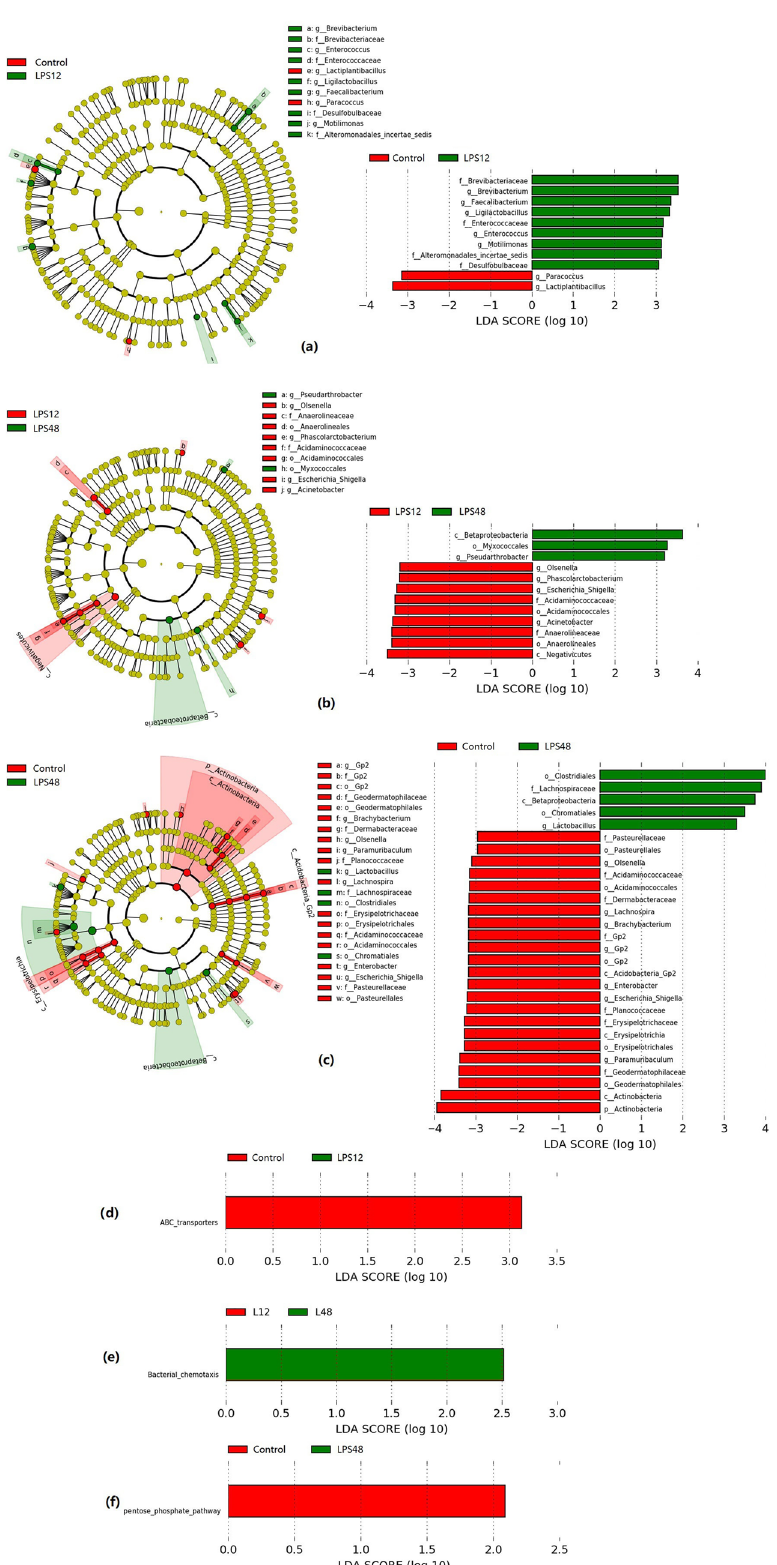
Figure 5. Linear discriminant effect size (LEfSe) analyses comparing differentially abundant taxa and Kyoto Encyclopedia of Genes and Genomes (KEGG) pathways between different groups. ( a – c ) Differences in the lung microbiota taxa between different groups. The phylogenic relationships between taxa with differences are shown in the cladogram. ( d – f ) Differences in the KEGG pathways predicted from the lung microbiota components between the different model